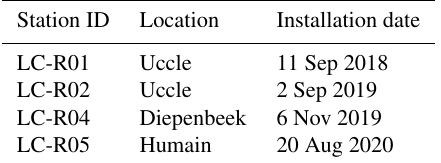
Table 3. Specifics of the Leuven.cool low-cost reference